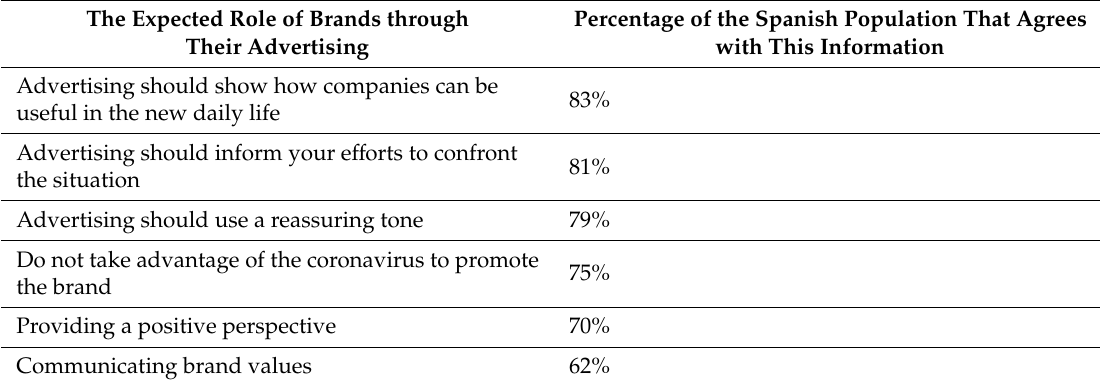
Table 1. Social function of advertising in Spain. Source: Own elaboration, Barometer COVID-19 [56,57]. The Expected Role of Brands through Percentage of the Spanish Population That Their Advertising